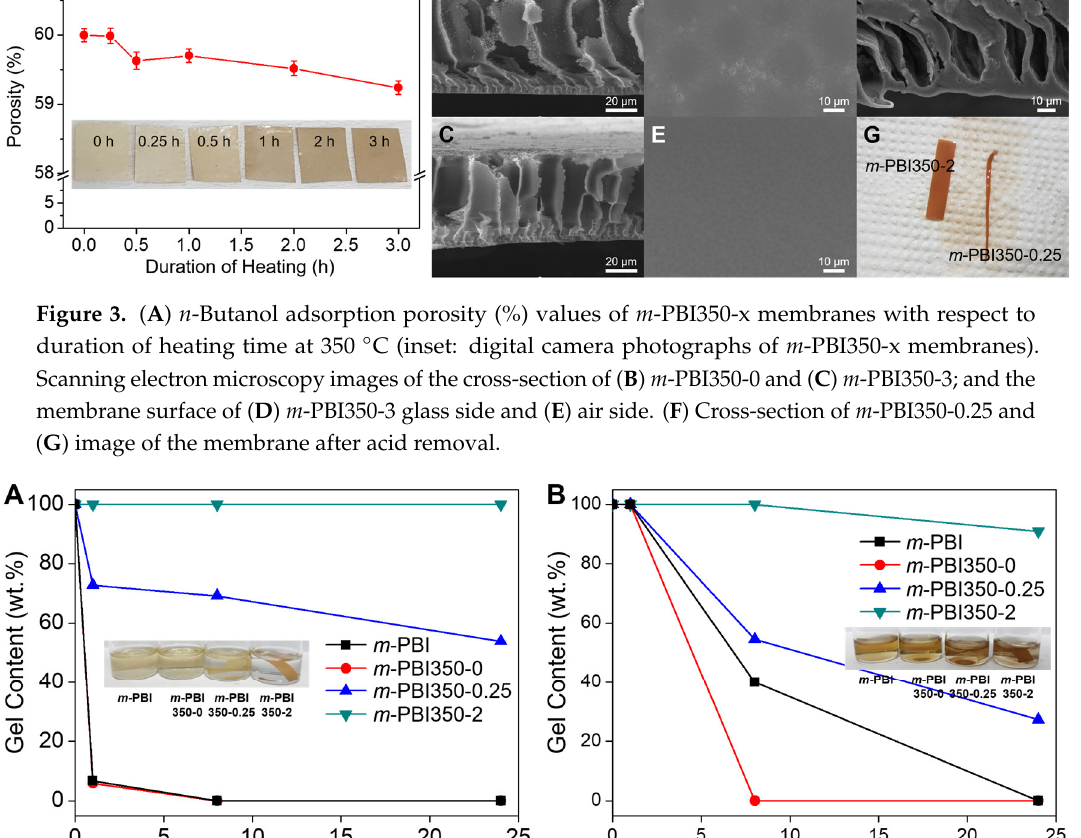
Figure 4. Solubility with respect to time in ( A ) dimethylacetamide (DMAc) (80 °C) and ( B ) phosphoric acid (PA) (160 °C). The inset images were captured after testing for 24 h.